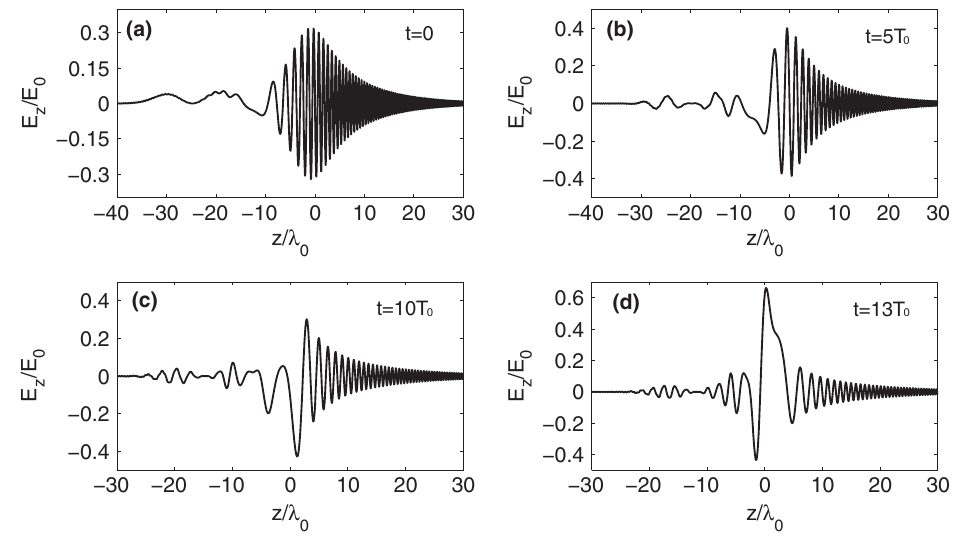
=E along the z axis at different times t ¼ 0 (a), t ¼ 5 T z 0 ¼ 1 : 5 (cid:7) , pulse duration t 0 0